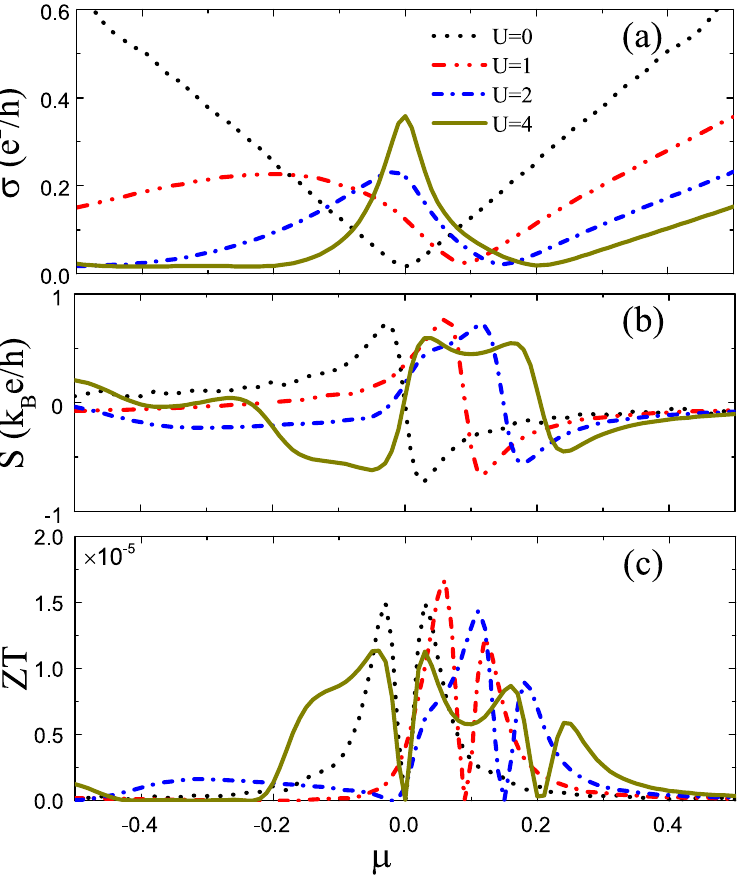
Figure 2. ( a – c ) Dependence on chemical potential μ of the electric conductivity σ , the thermopower S , and the figure of merit ZT for different scalar potential U = 0, 1, 2, 4. The other parameters are the same as in Fig.